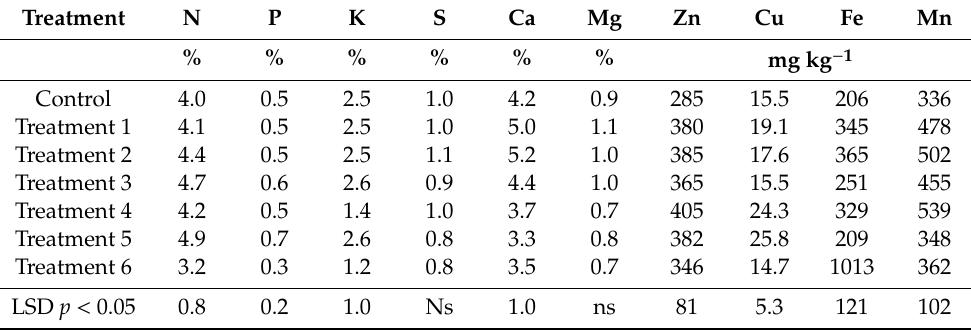
Table 3. E ff ect of poultry litter manure, biochar, and conventional fertilizers on nutrient concentrations in cucumber